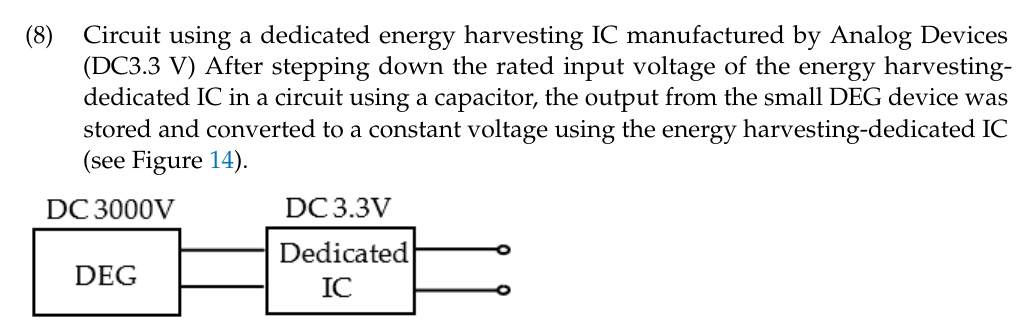
Figure 14. Circuit using a dedicated energy harvesting IC manufactured by Analog Devices (DC3.3